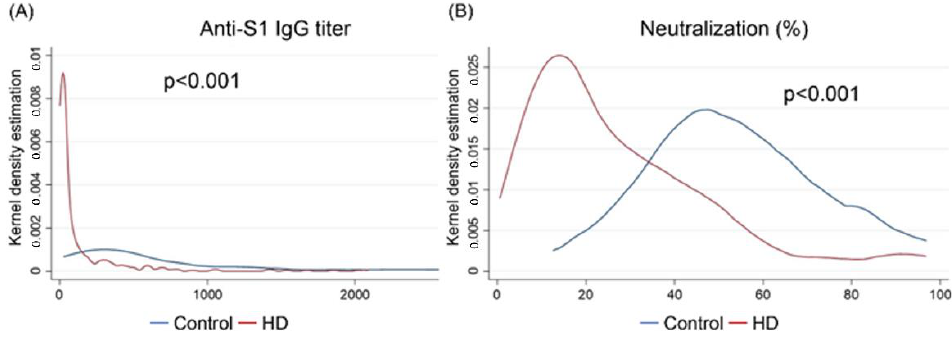
Figure 3. Kernel density estimations for anti-S1 IgG titers ( A ), and sVNT-measured neutralization ( B ), between the control group and hemodialysis patients. Abbreviations: AU, arbitrary unit; HD, hemodialysis; S1, the S1 sub-unit of the spike protein; sVNT, surrogate virus neutralization test.